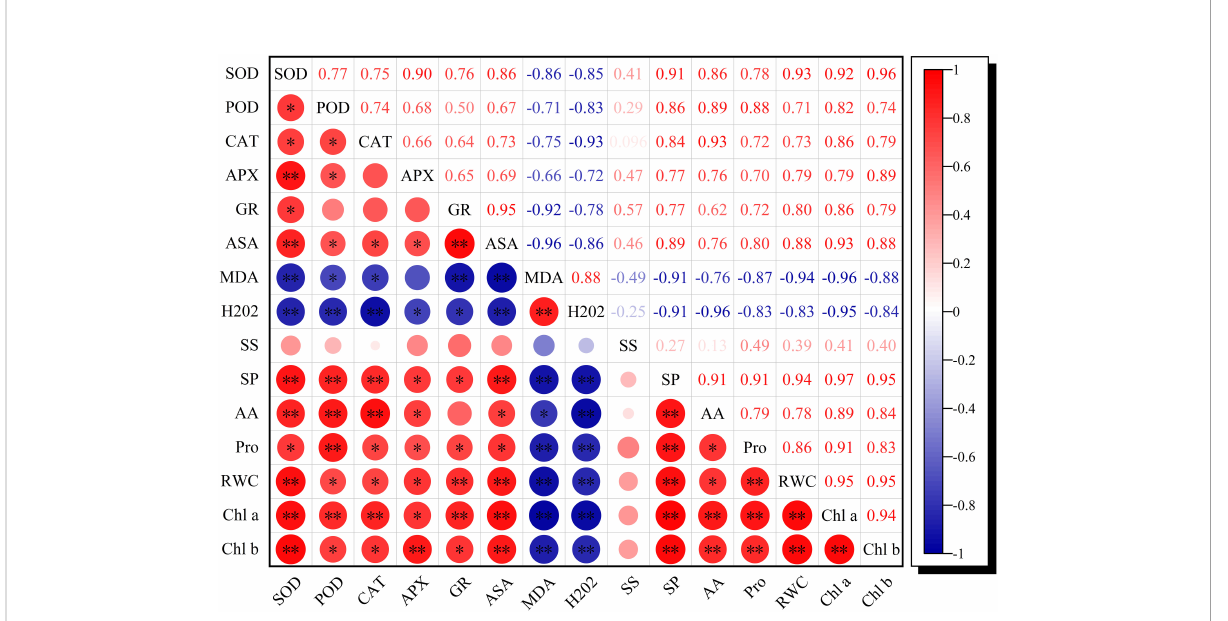
FIGURE 6 Correlation coef fi cients of RWC, Chl a , Chl b , ROS metabolism, and osmoregulation-related traits exposed to K and drought stress. n = 9, R fi cant differences at the P <0.05 and P <0.01 probability levels, R 0.05 = 0.6664, 0.01 = 00.7977. * and ** indicate signi